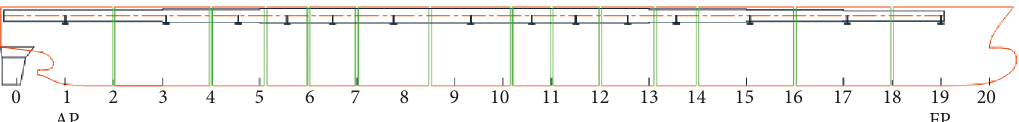
Figure 6: Schematic drawing of the installation of backbone in ship model.